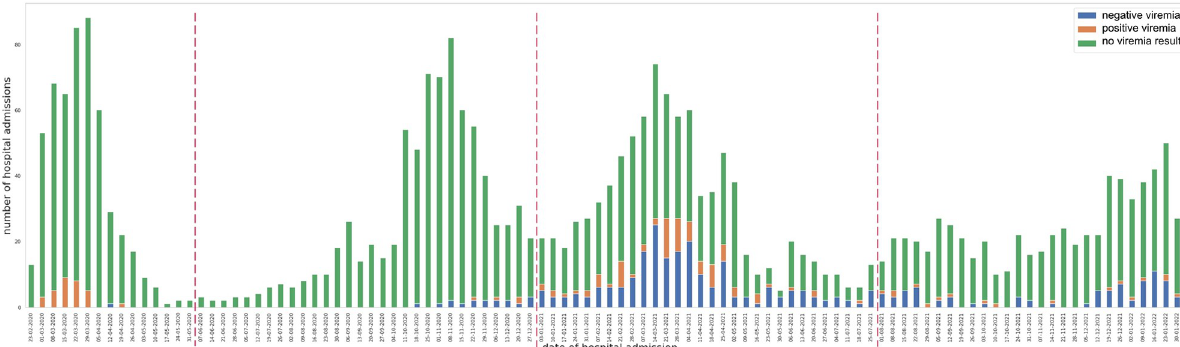
Fig 1. Stacked bar chart. Number of hospital admissions with positive, negative viremia and with no viremia result.